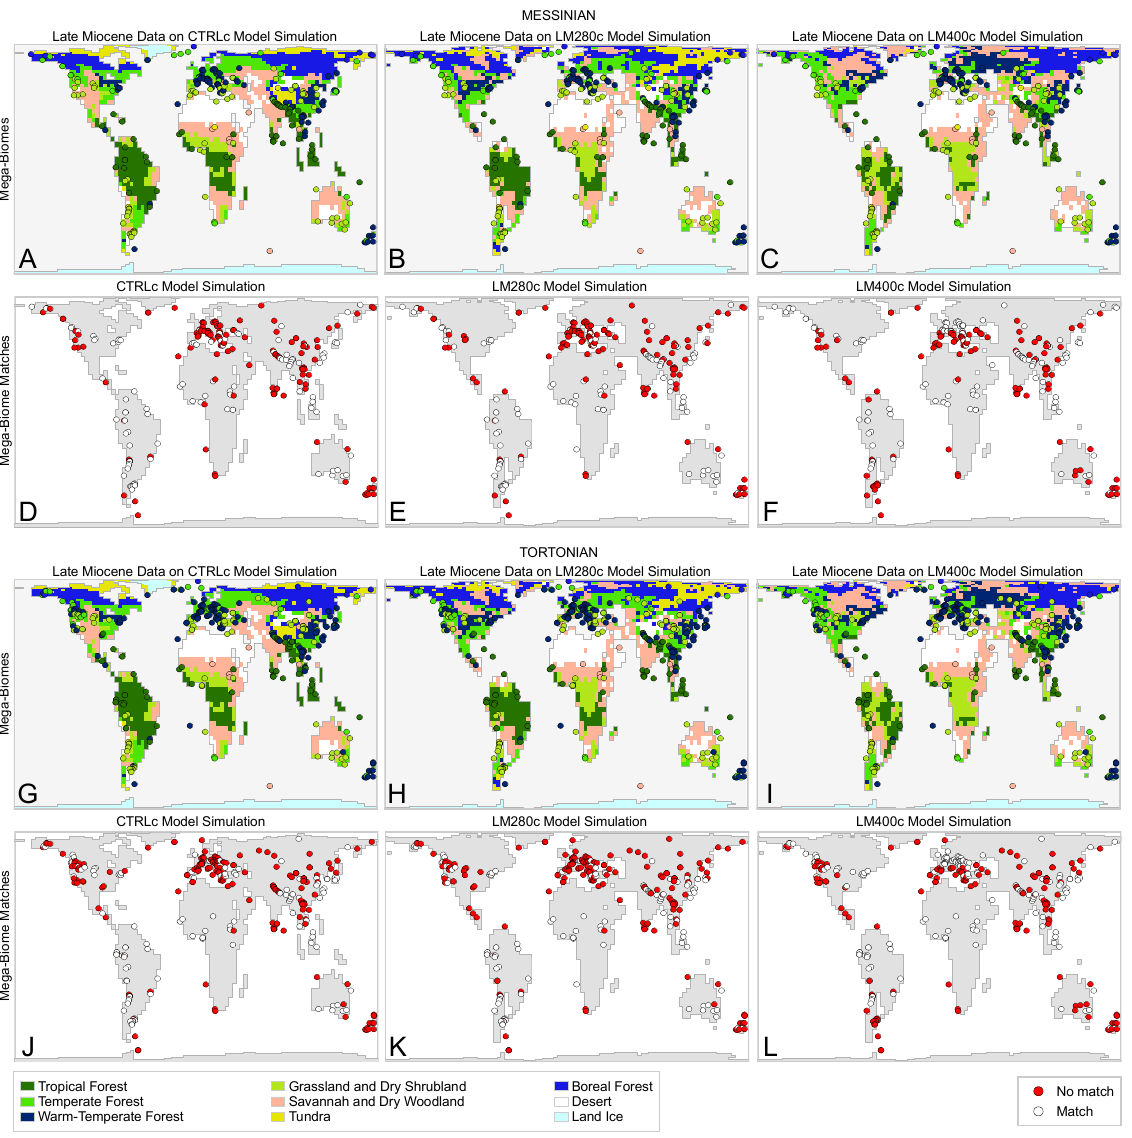
Fig. 15. Results from the model–data comparison for megabiomes: late Miocene data on CTRLc, LM280c, and